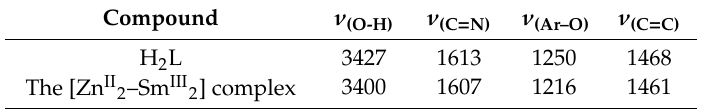
Table 2. Main infrared data (cm − 1 ) for H 2 L and the [Zn II 2 –Sm III 2 ] complex.